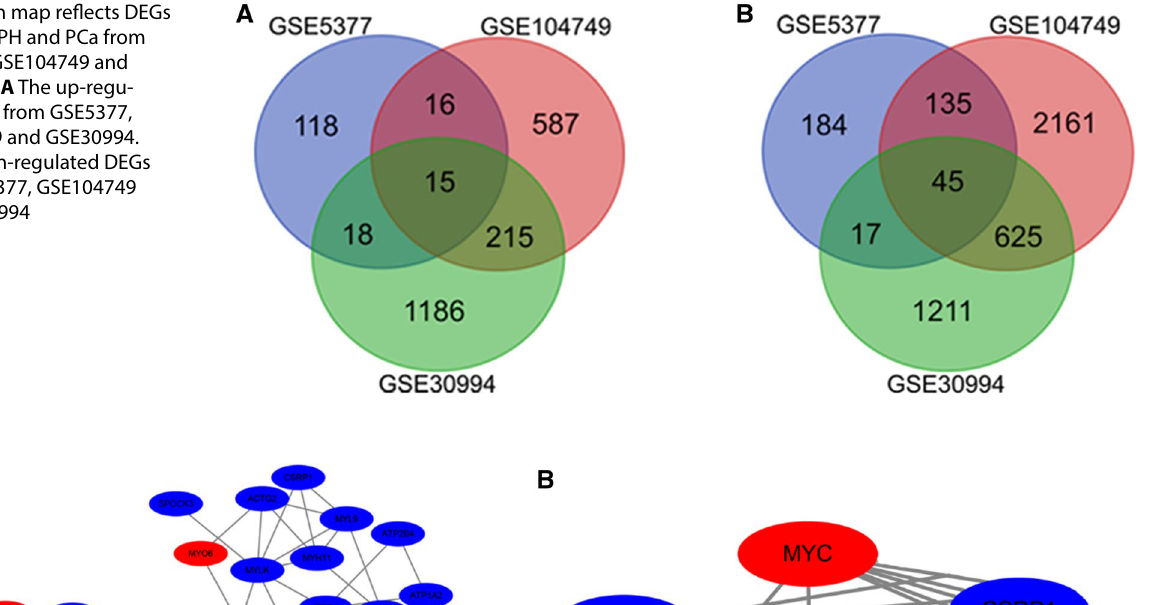
Fig. 1 Venn map reflects DEGs between BPH and PCa from GSE5377, GSE104749 and GSE30994. A The up-regu- lated DEGs from GSE5377, GSE104749 and GSE30994. B The down-regulated DEGs from GSE5377, GSE104749